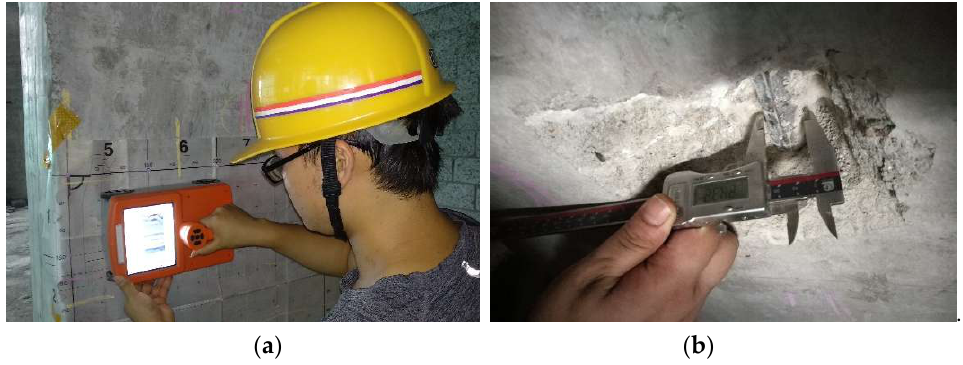
Figure 12. Photos of ( a ) the field operation and ( b ) the drilling measurement.